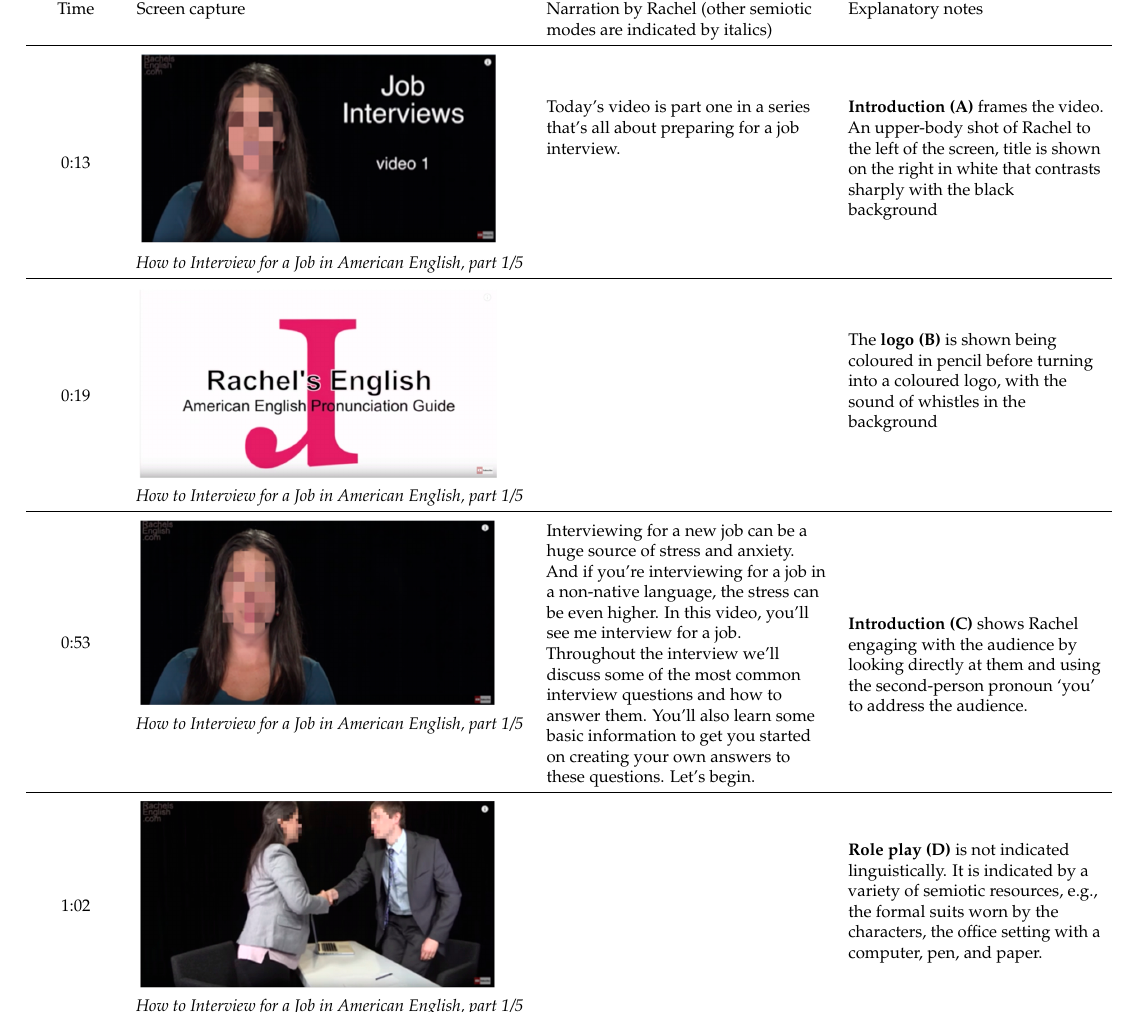
Table 3. A multimodal view of the lesson.